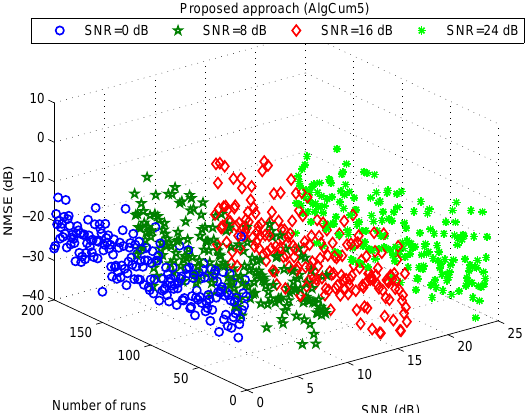
Figure 14. Comparison of NMSE in estimating the system II for different SNR and data input lengths N .